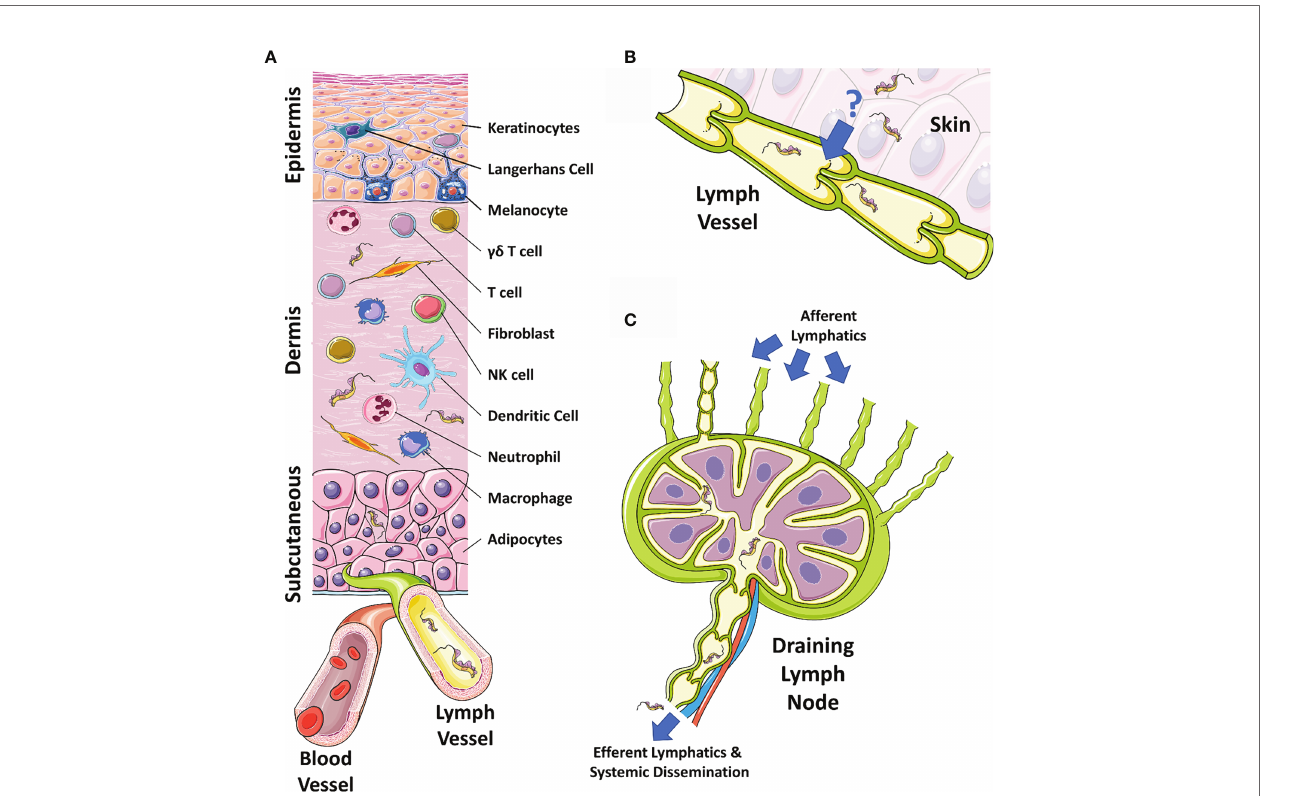
FIGURE 1 | The skin, draining lymphatics, and lymph nodes. (A) Diagram of the cellular composition ofthe epidermal, dermal, andsubcutaneous layers of mammalianskin. The outermost epidermal layer consists of a layer of corneocytes above a layer of keratinocytes. These cells manage the tight junctions andthe stratum corneum. Langerhans cells and intraepithelial T cells survey the epidermis for antigento be presented. The central dermal layer contains fi broblasts that produce extracellular matrix proteins to provide structural support andelasticity. Immune responses are initiated bydermal macrophages, dermal dendritic cells, NK cells, and T cells. The inner subcutaneous layer primarily consists of adipocytes. Local lymphatic and bloodvessels allow for the traf fi cking of cells, proteins, and waste. The initial tsetse fl ybite injects trypanosomes into the dermis. From the dermis, the parasites exhibittropism that leadsto migration toward the afferent lymphvessels inthe skin disseminating to the blood and other regions of the body. (B) The mechanism behind directional migration of trypanosomes from the skin to the lymphatics is unknown. Parasites may be responding to anunreportedchemical cue ina chemotactic manner and they may crawl along lymph vessels, access open junctions, or are drawninto the lymphatics through hydrodynamic fl ow force and pressure. (C) Afferent lymphaticvesselsin the skinallow for the drainage ofleukocytes and antigeninto the draining lymph node. Lymph, containing activated T and B cells, plasma cells, and antibody, passes into the medullarysinus, before exiting via efferent lymphatic vessels. Trypanosomes enter the draining lymphnodes, causing lymphadenopathy, and exit via the efferent lymphatics. Systemic disseminationofthe host is reachedvia the main lymphatic ducts. The fi gure uses art adapted from materialprovidedby Servier Medical Art under a Creative Commons Attribution3.0 Unported License